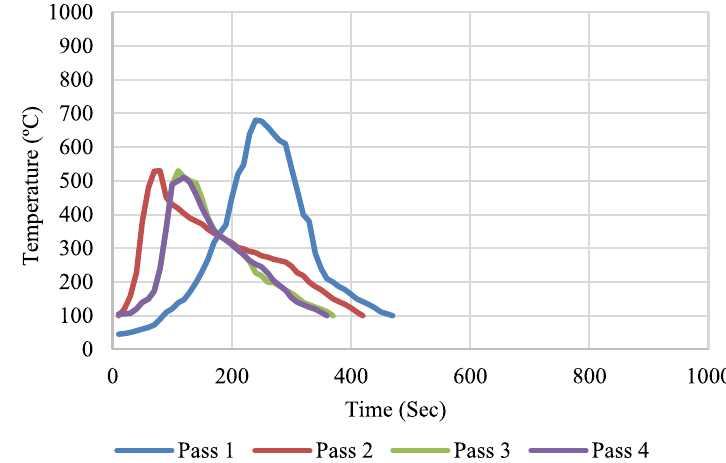
Fig. 9 Temperature cycle for single bevel using AWS A 5.9 ER 307 with cooling